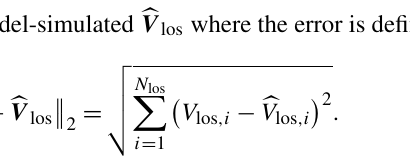
to the number N los of V los measurements